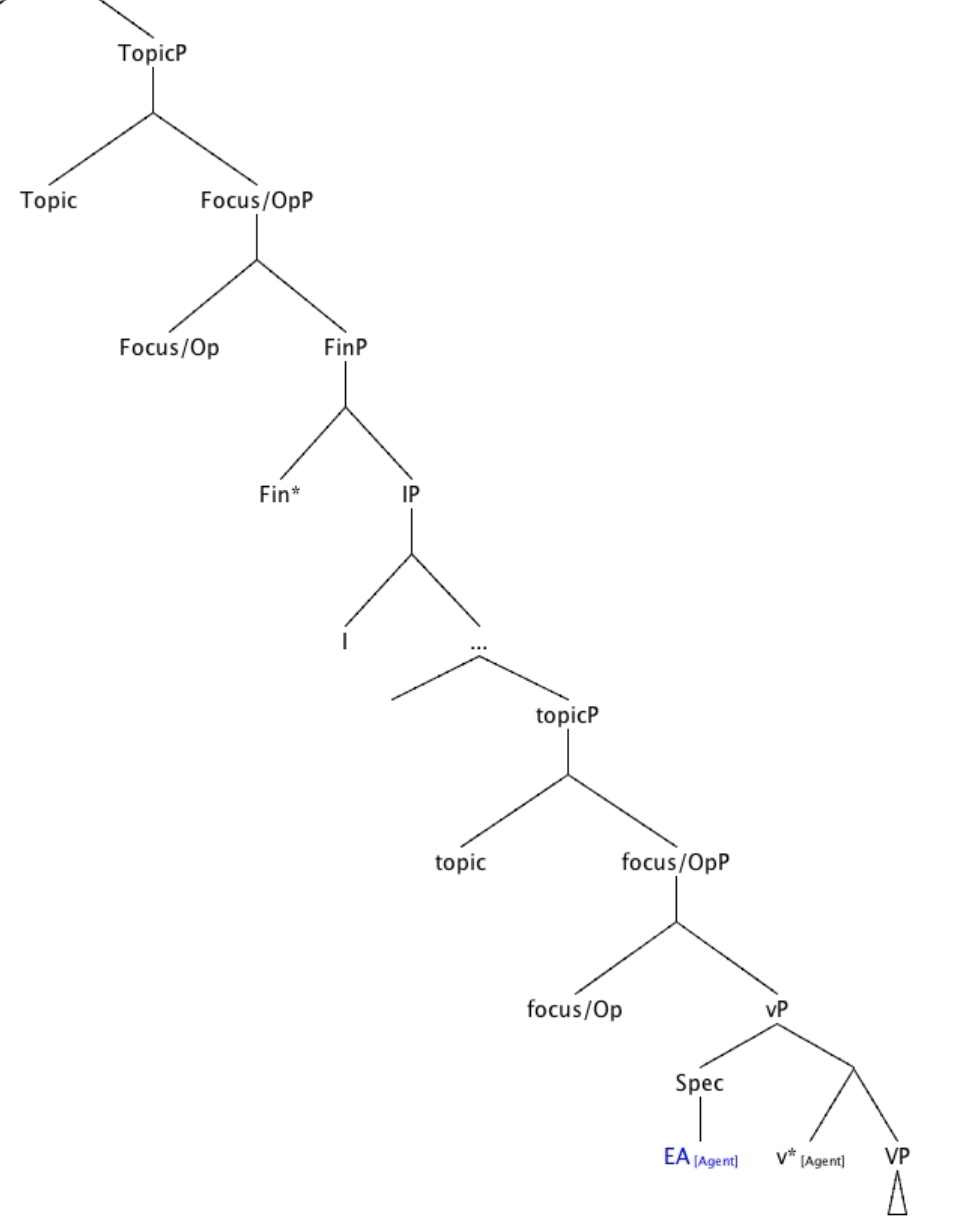
Figure 1 . Old Italian active clause